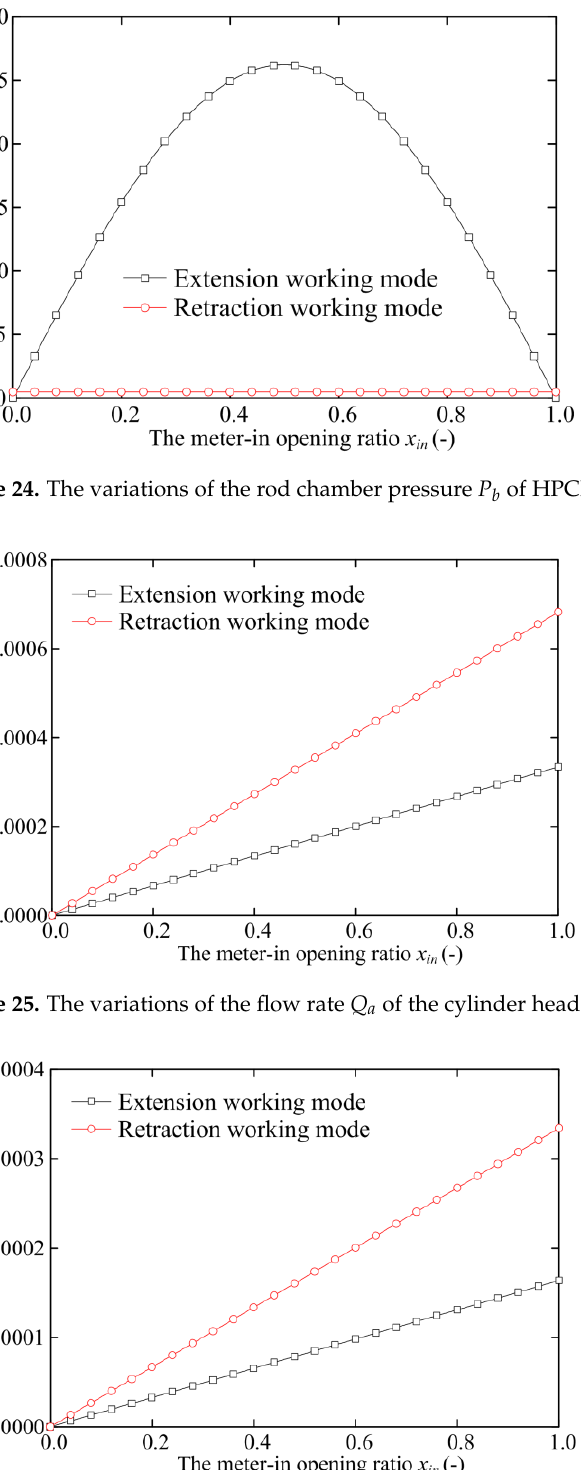
Figure 23. The variations of the head chamber pressure P a of HPCIMS.